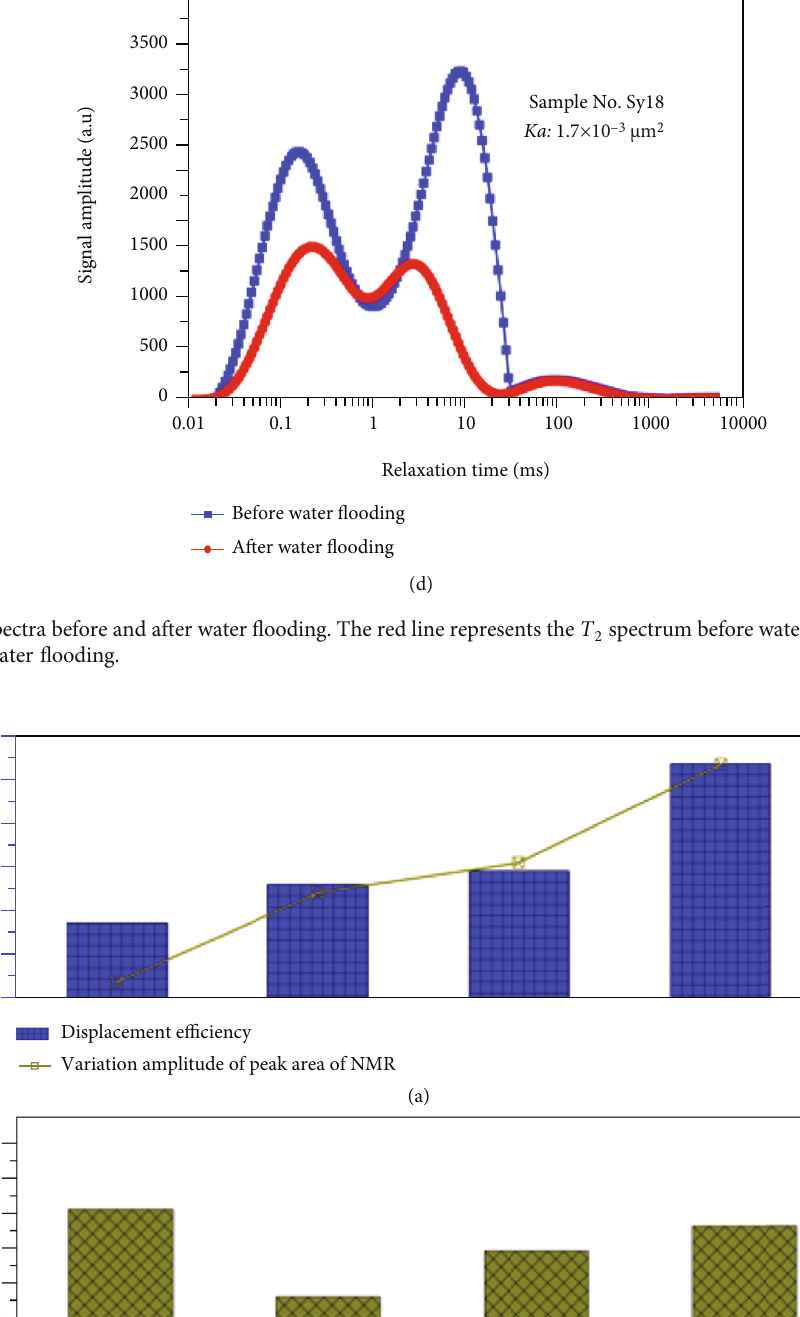
Figure 13: The relationships between the displacement e ffi ciency and the variation in the amplitude of the peak area of the NMR before and after water fl